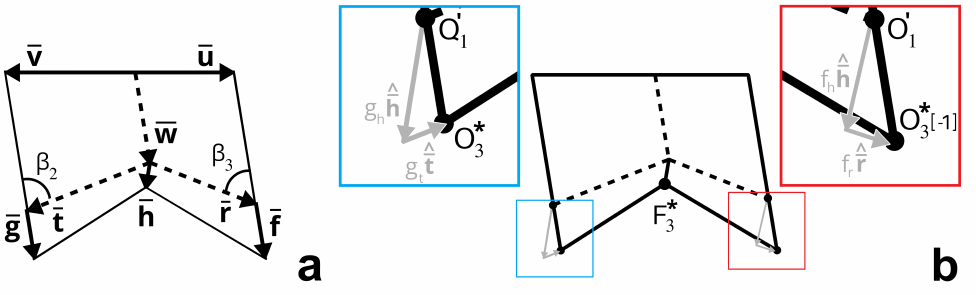
Figure 8. ( a ) Vectors in S 4 . ( b ) Vector components of ¯ f and ¯ g